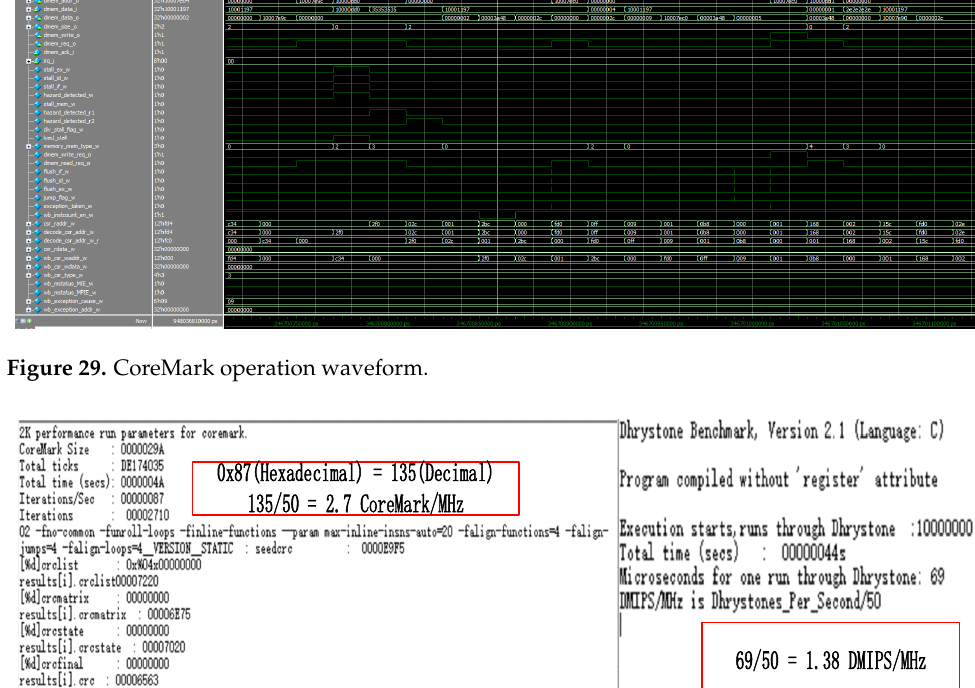
Figure 29. CoreMark operation waveform.